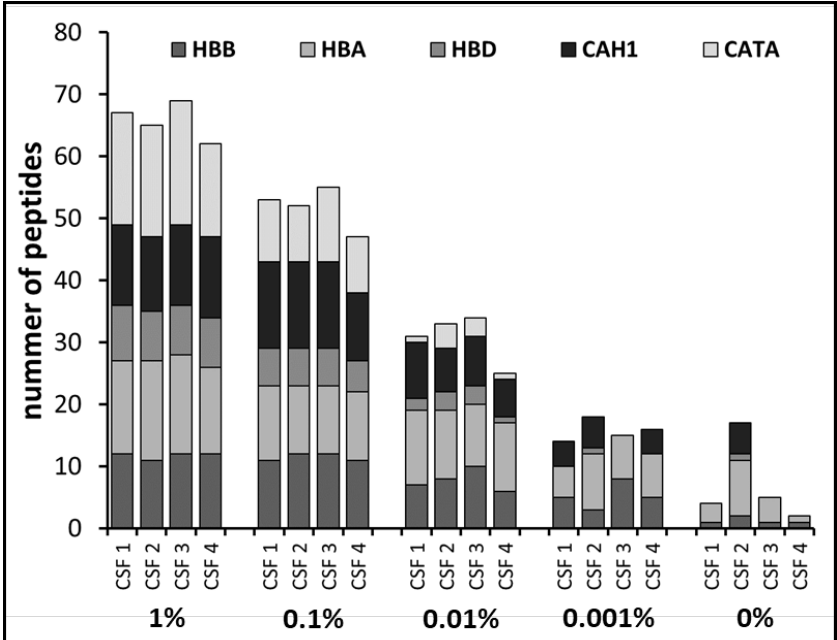
Figure 3. Identification of the selected blood proteins. Shown is the number of identified peptides for hemoglobin including subunit alpha (HBA), beta (HBB), and delta (HBD), carbonic anhydrase 1 (CAH1), and catalase (CATA) within the CSF samples of four different individuals (CSF 1 to CSF 4) and the respective blood spike-in levels, ranging from 0.001% to 1%. In all samples, hemoglobin (HB) was detected, while CAH1 and CATA were consistently identified in samples with increased blood levels. Furthermore, increasing blood levels led to enhanced peptide identification per protein.